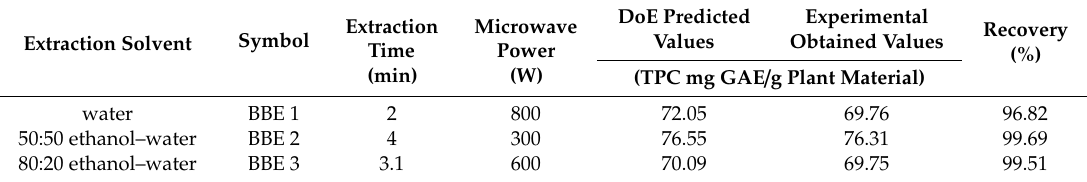
Table 3. Optimal extraction parameters, DoE predicted and experimental obtained values of the extracted